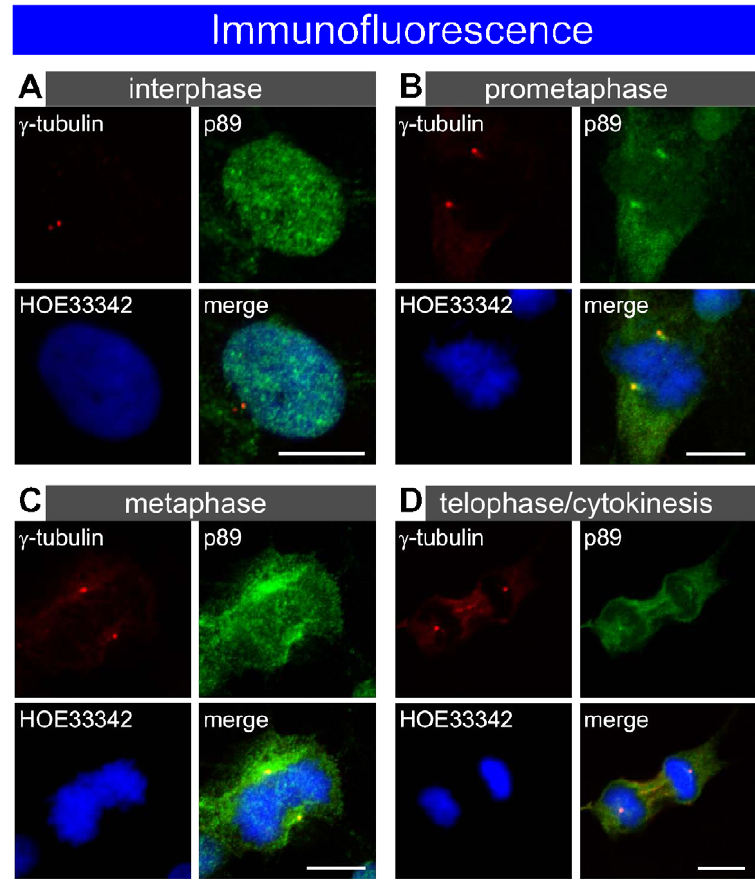
Fig. 1. The TFIIH subunit p89 localizes to the centrosome during mitosis. (A) Immunofluorescence staining in interphase cells shows p89 in a finely stippled pattern in the nucleus. No signal is detectable at the interphase centrosome. Starting from prometaphase (B), in metaphase (C) and until telophase/cytokinesis (D), a strong signal is detected at the centrosome and adjacent mitotic spindle. Scale bars = 10 µm. Red – γ -tubulin, green – p89; blue –